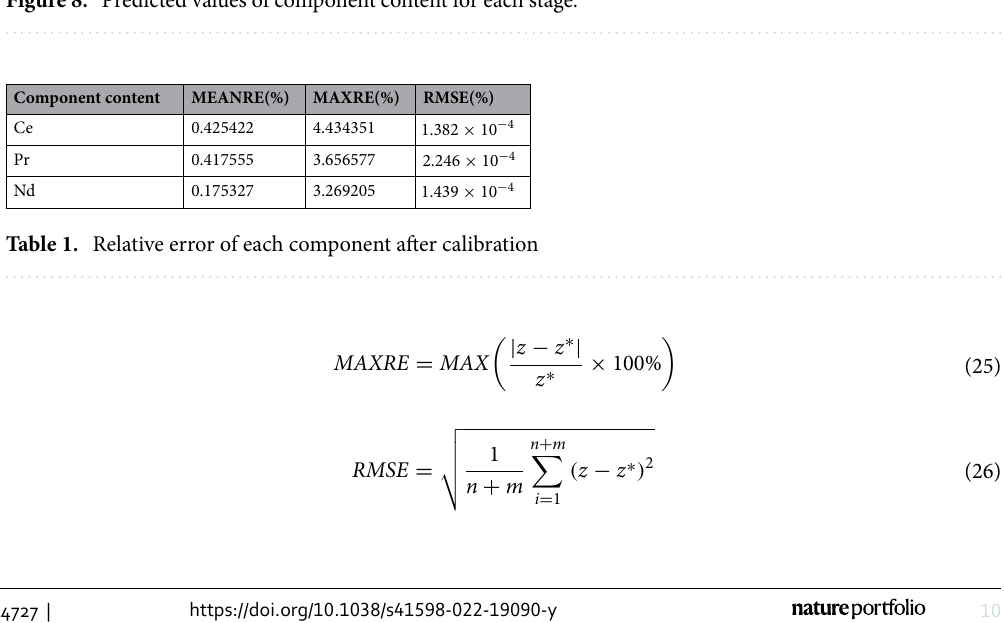
Figure 8. Predicted values of component content for each stage.